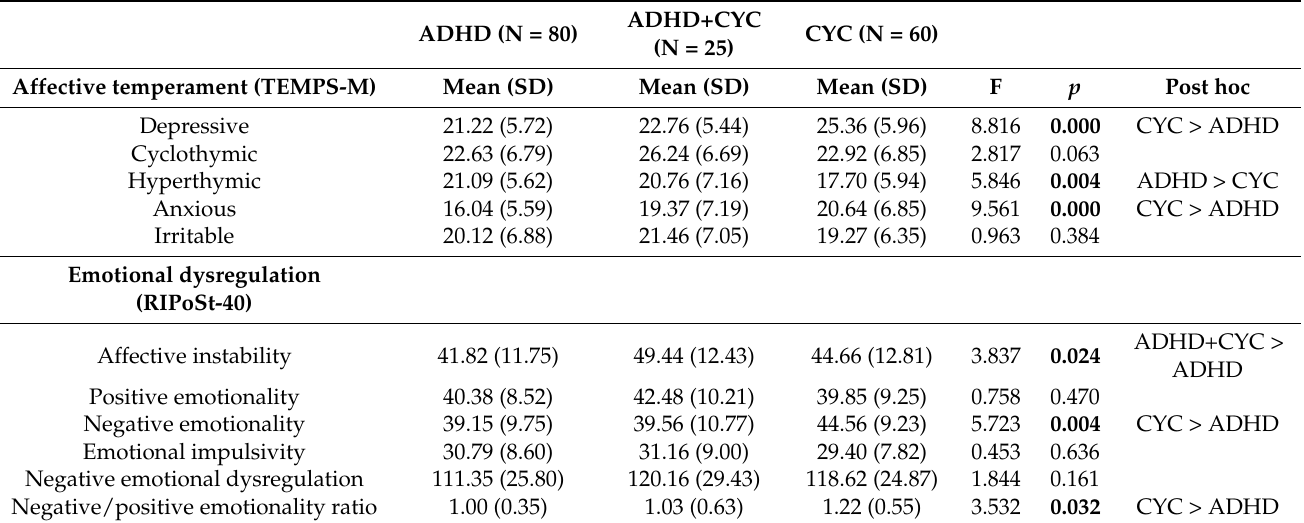
Table 2. Differences in affective temperamental traits (TEMPS-M subscales) and emotional dysregulation facets (RIPoSt-40) among patients with ADHD, cyclothymia (CYC), or both (ADHD+CYC). One-way ANOVA results are displayed. F-statistics are reported. p -values < 0.05 are shown in